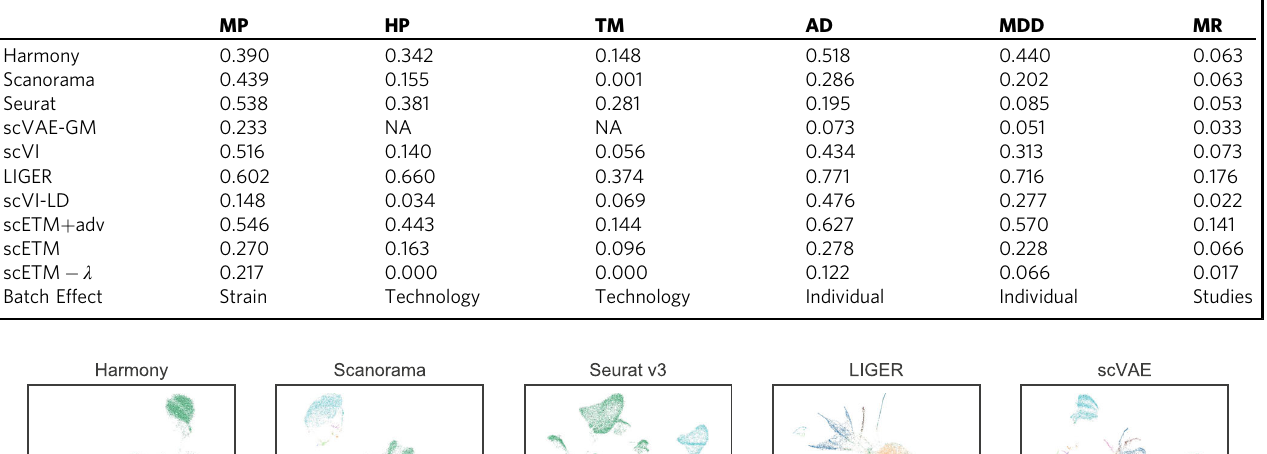
Table 2 Batch correction performance on data integration tasks. The batch correction performance is measured by kBET 18 . More details are described in Table 1 caption and Methods.